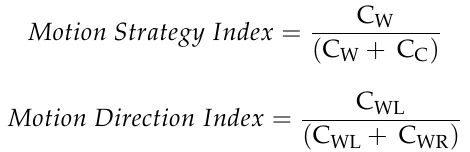
Figure 2. Experimental conditions. Proximal–Short (PS), top left; Proximal–Long (PL), top right; Distal–Short (DS), bottom left; Distal–Long (DL), bottom right (3D virtual graphic reconstruction by Sara